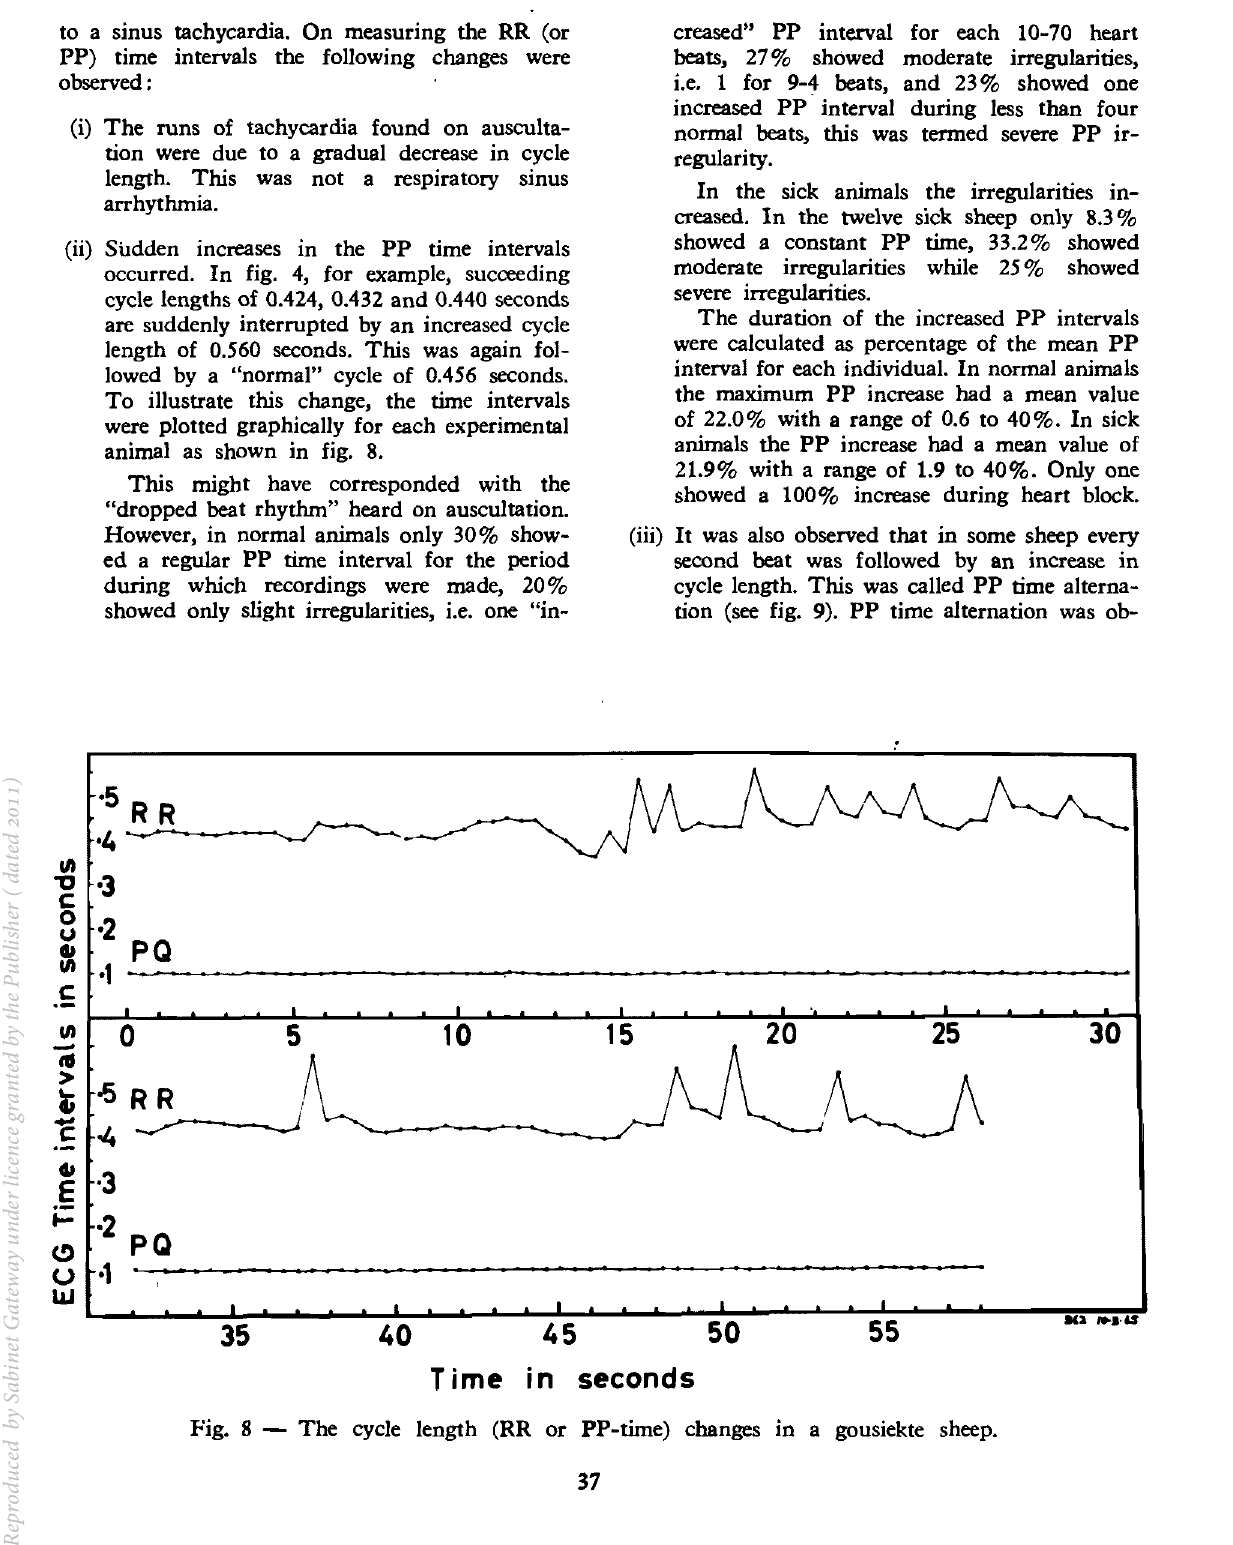
Fig. 8 - The cycle length (RR or PP-time) changes in a gousiekte